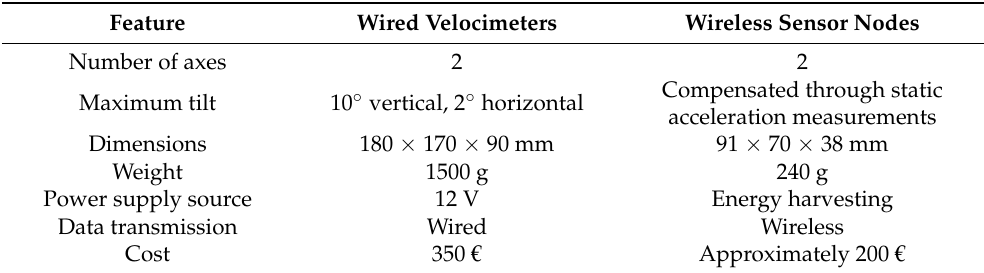
Table 3. Comparison between main features of wired velocimeters and wireless sensor